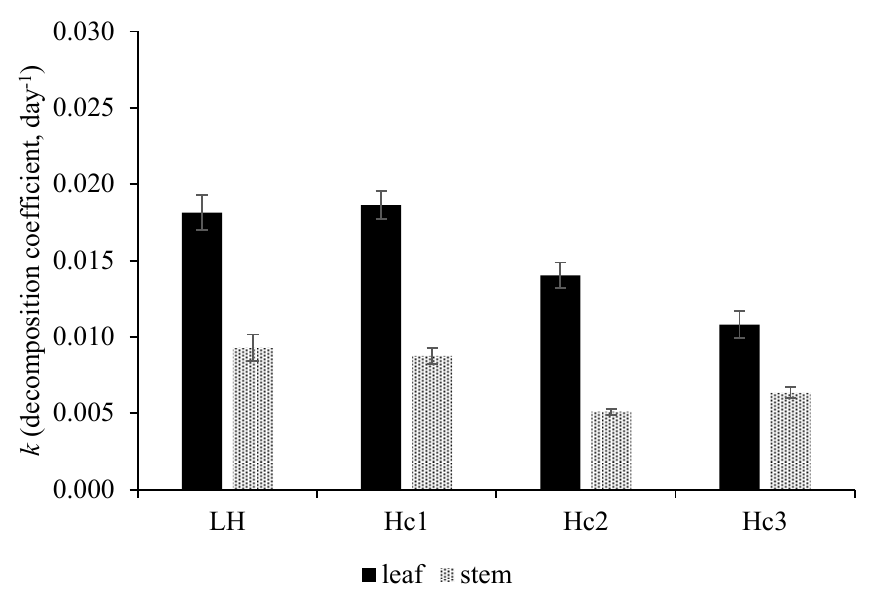
leaf stem Figure 2. Decomposition coefficients (k) of goldenrod leaf and stem in Lake H é v í z and its canal Figure 2. Decomposition coefficients (k) of goldenrod leaf and stem in Lake Hévíz and its canal (Hc1-3) (mean ± SD). (Hc1-3) (mean ± SD). Table 3. Tests of within-subjects effects of goldenrod stem mass loss (g) in Lake H é v í z and through H é v í z canal.